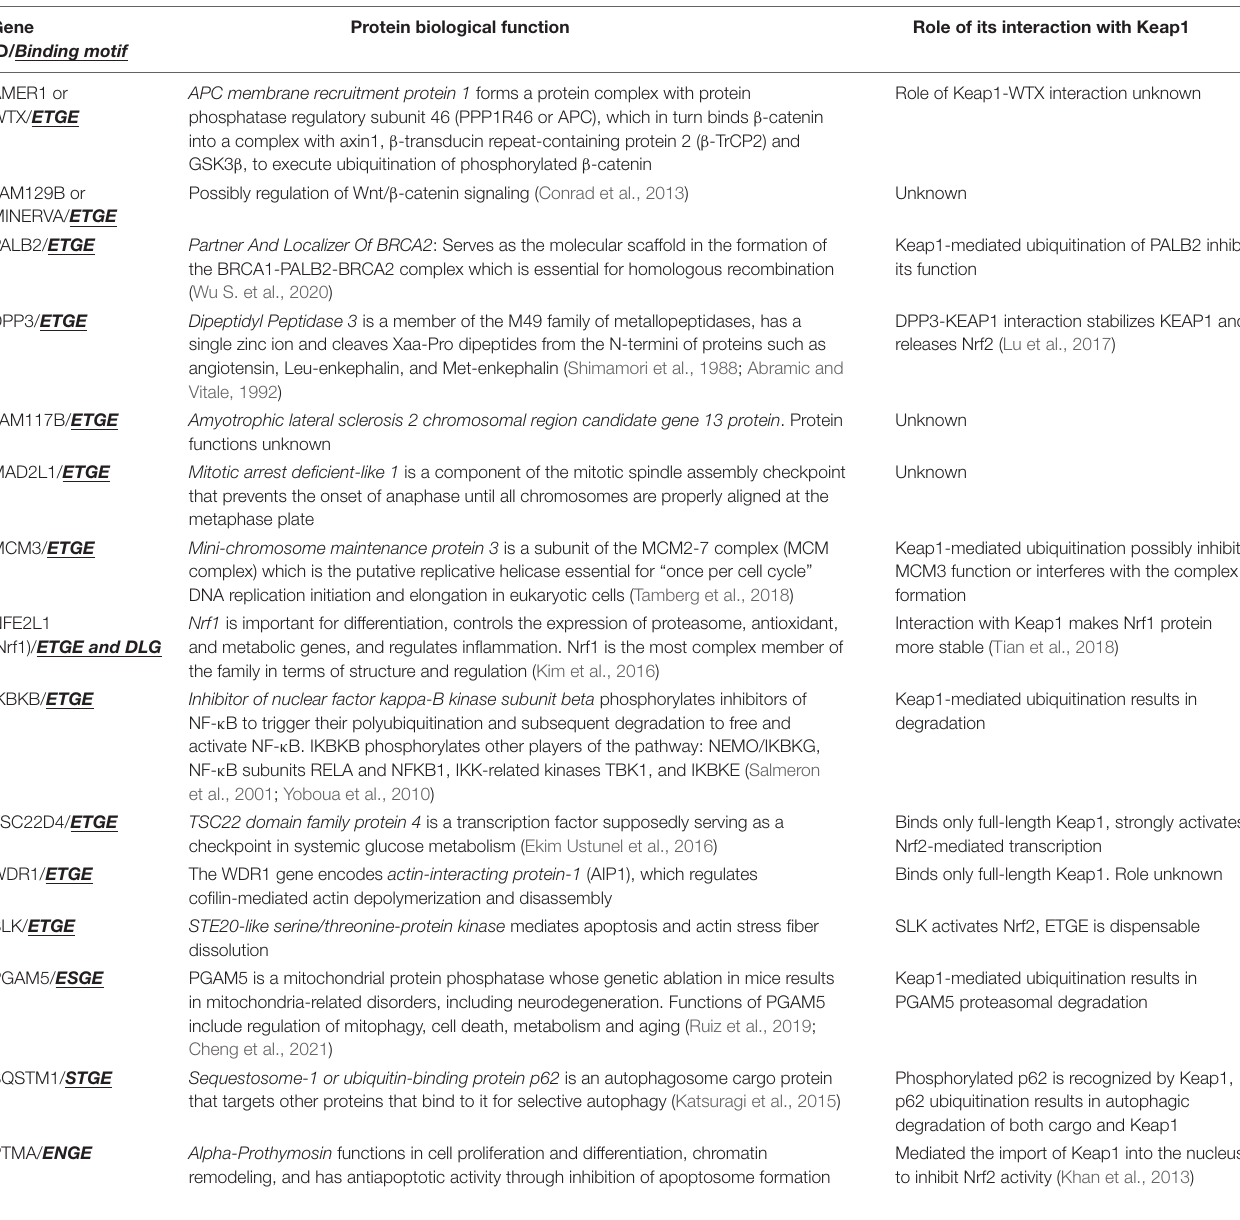
TABLE 1 | Verified Keap1 client proteins (in addition to